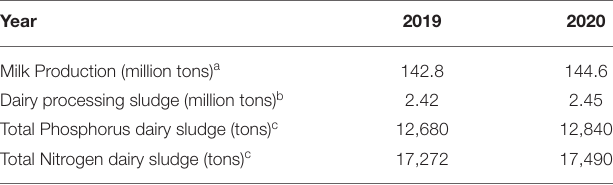
FIGURE 1 | Global P resources and consumption of P and associated P usage streams in the EU in tons per year. Based on Ott and Rechberger (2012), Scholz and Wellmer (2013), and Schoumans et al. (2015). TABLE 1 | EU domestic milk intake and associated estimated dairy processing sludge generation (wet weight) with total phosphorus and nitrogen